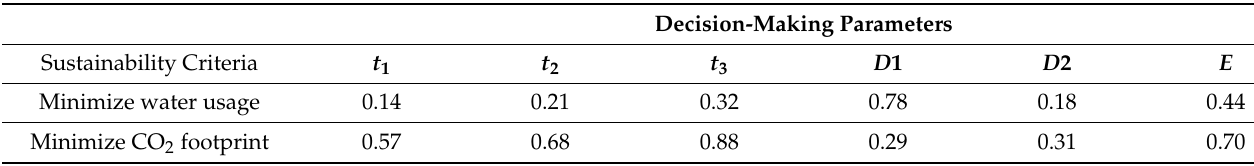
Table 7. Sustainability reassessment of wooden materials.